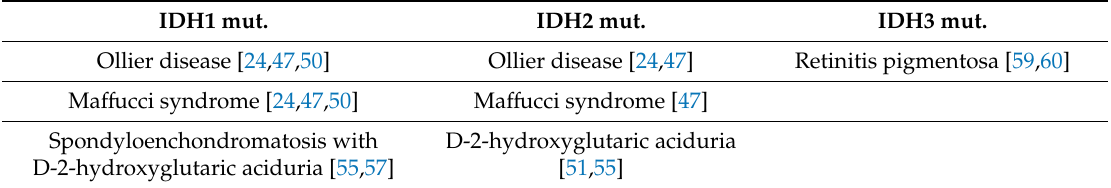
Table 1. Isocitrate dehydrogenase (IDH) mutations in genetic